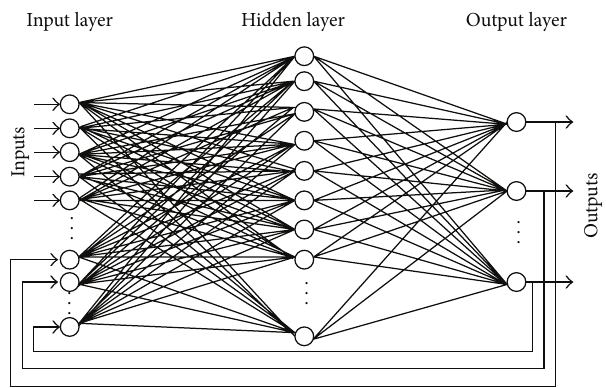
Figure 5: A recurrent neural network, notice the output being recurrently fed into the input